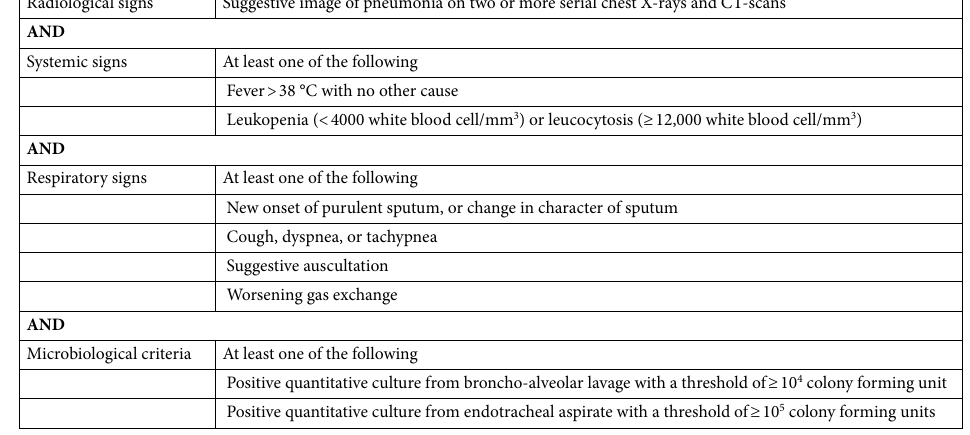
Table 1. Diagnostic criteria of ventilator-associated